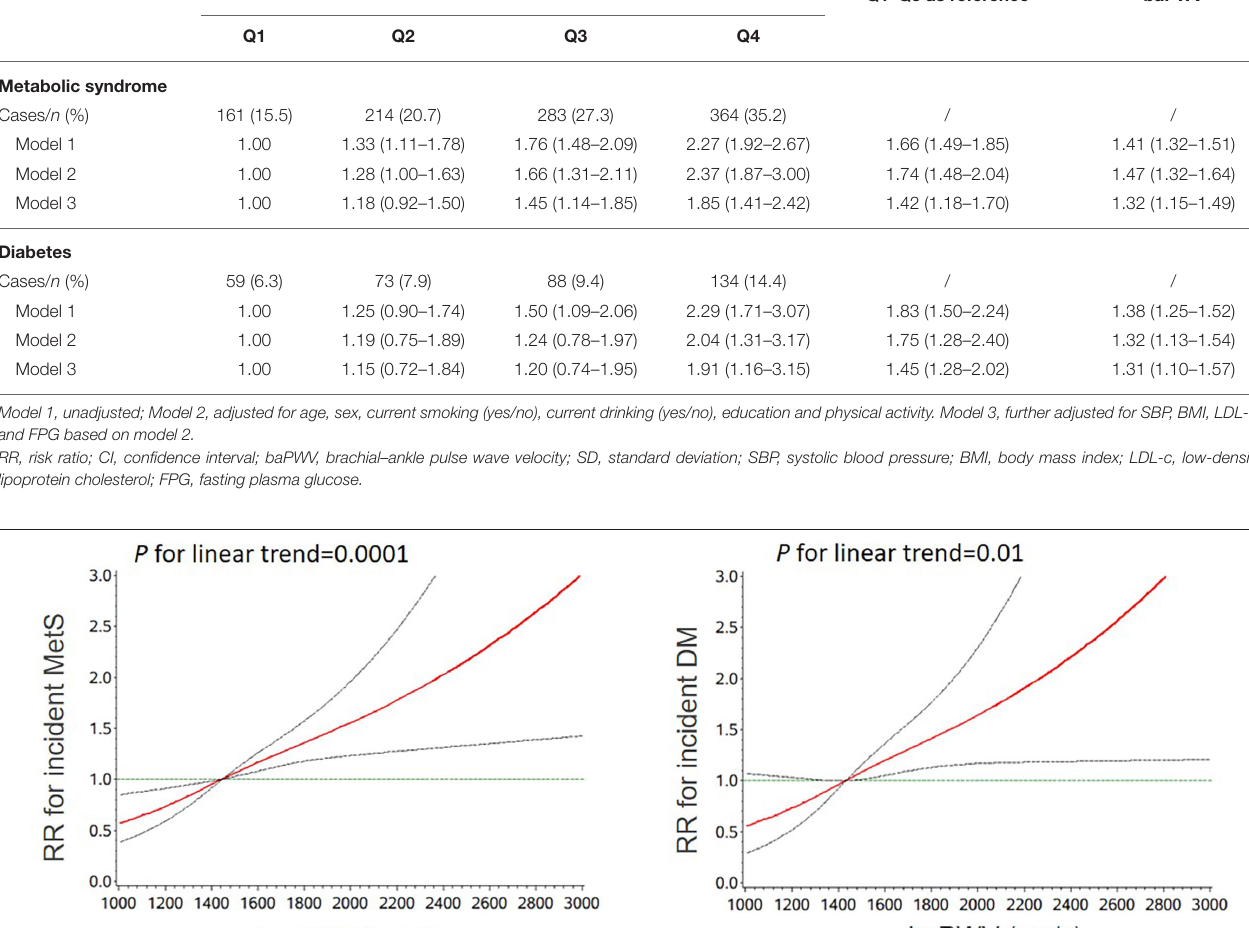
Per SD increment of Q1–Q3 as reference baPWV